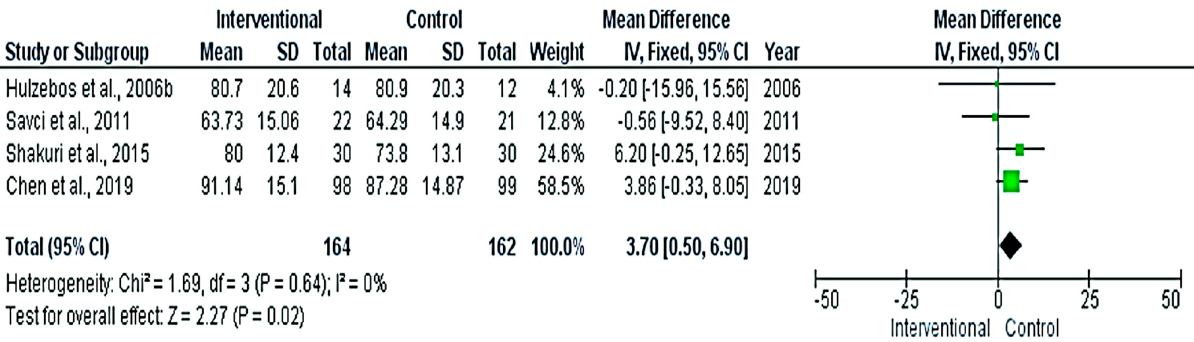
Figure 5. Forest plot evaluating hospital stay length in the included studies.